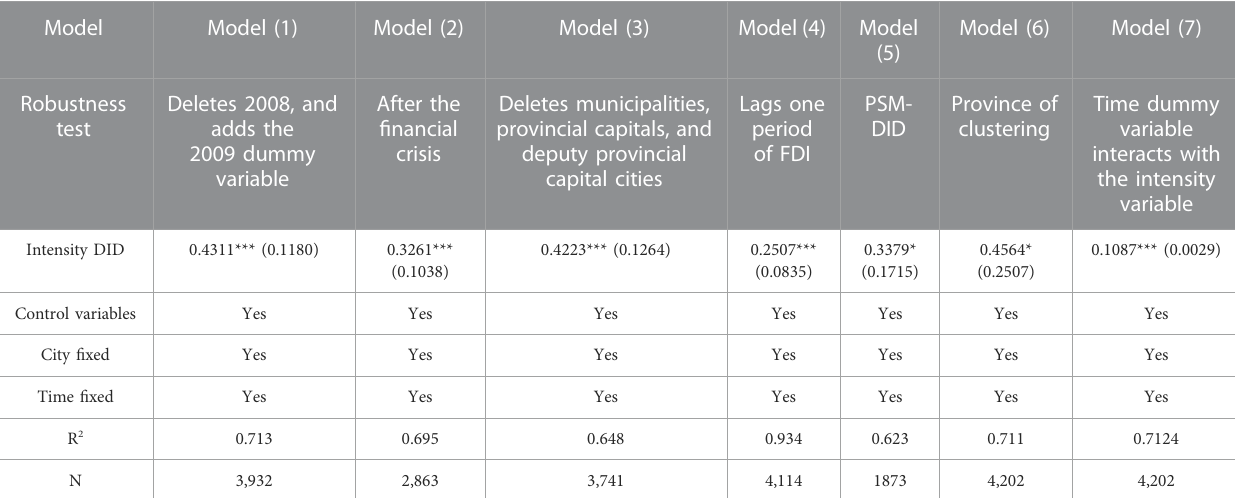
TABLE 6 Robustness